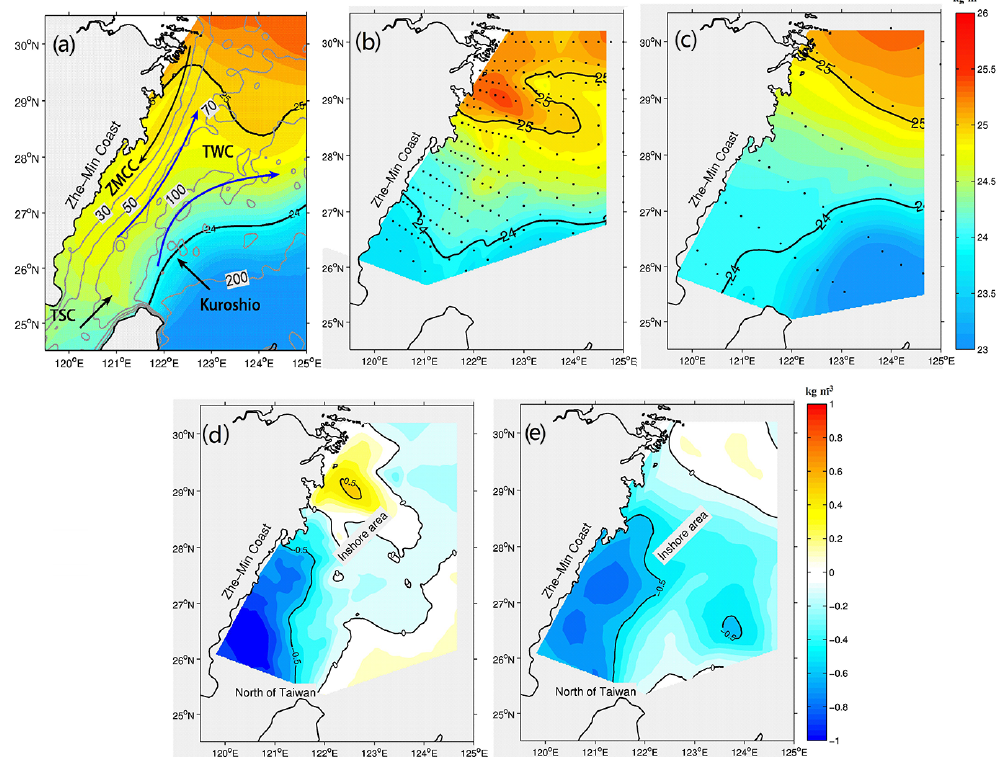
Figure 1. Density ( σ t , kgm 3 ) distributions at 50m depth derived from the GDEM climatological data in February (a) , an ocean survey from 1 to 27 February 2007 (b) , an ocean survey from 3 to 16 February 2007 (c) and the density anomalies between the GDEM data and the two surveys (d, e) . The two blue arrows indicate the two TWC branches in winter. The 30, 50, 70, 100 and 200m isobaths are indicated with gray lines in (a)